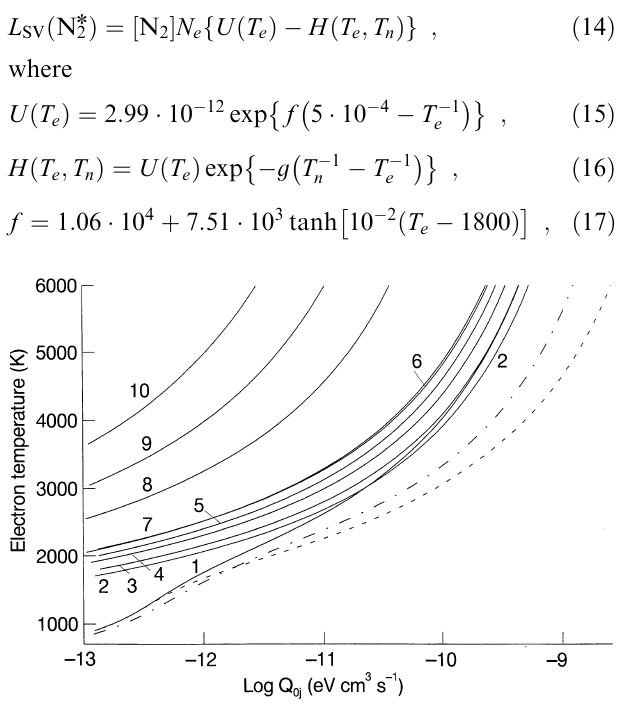
P 9 Q 1 v (cid:136) 2